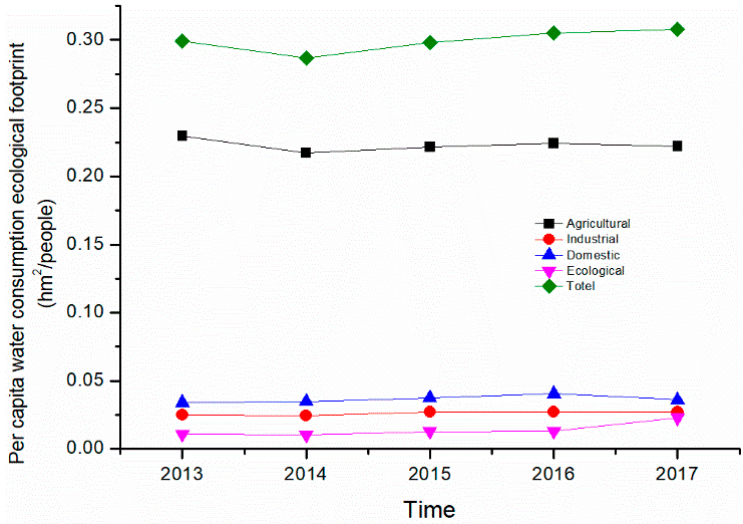
Figure 3. The PCWCEF of the lower reaches of the Yellow River in 2013–2017.